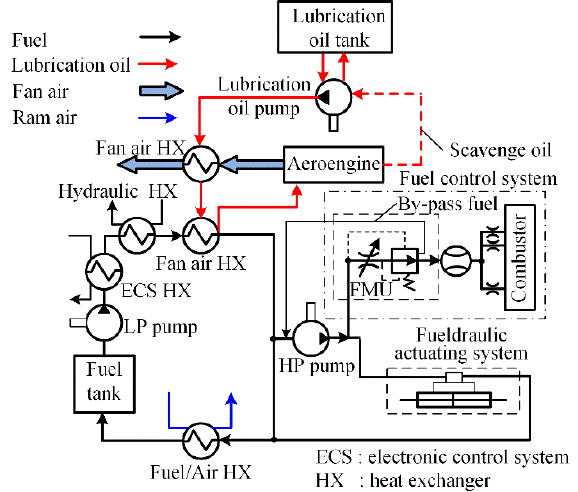
Figure 2. Fuel-based thermal management system.